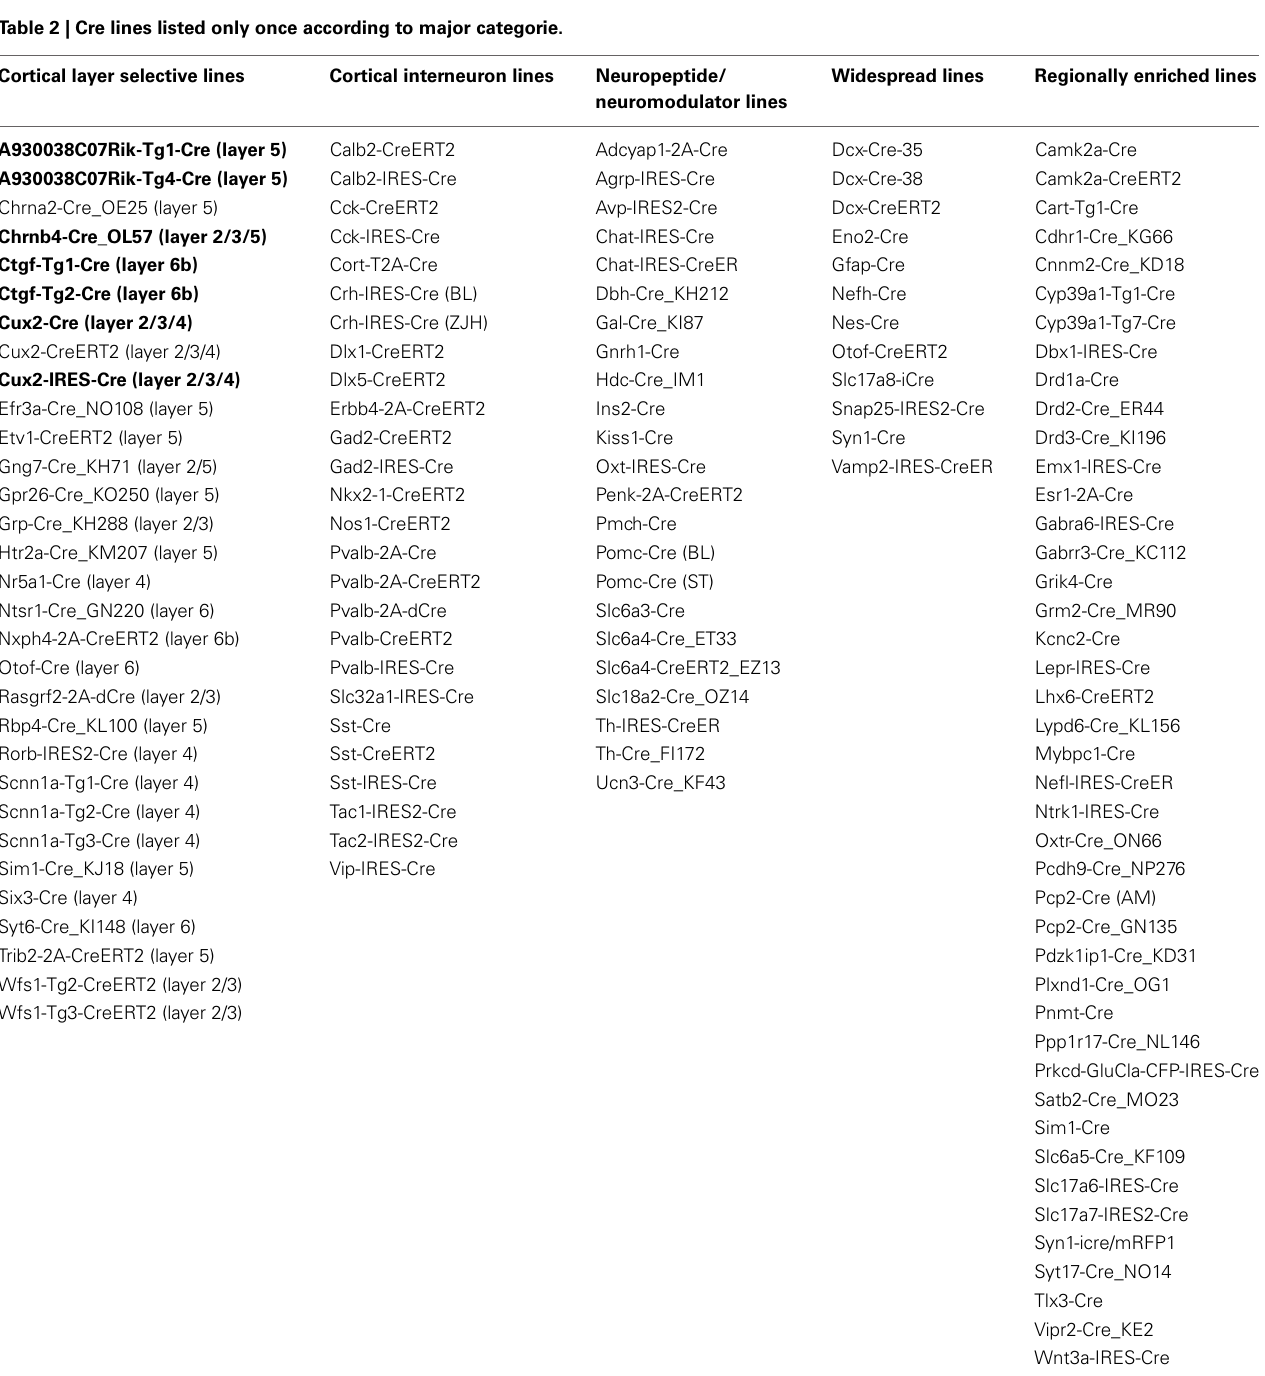
Table 2 | Cre lines listed only once according to major